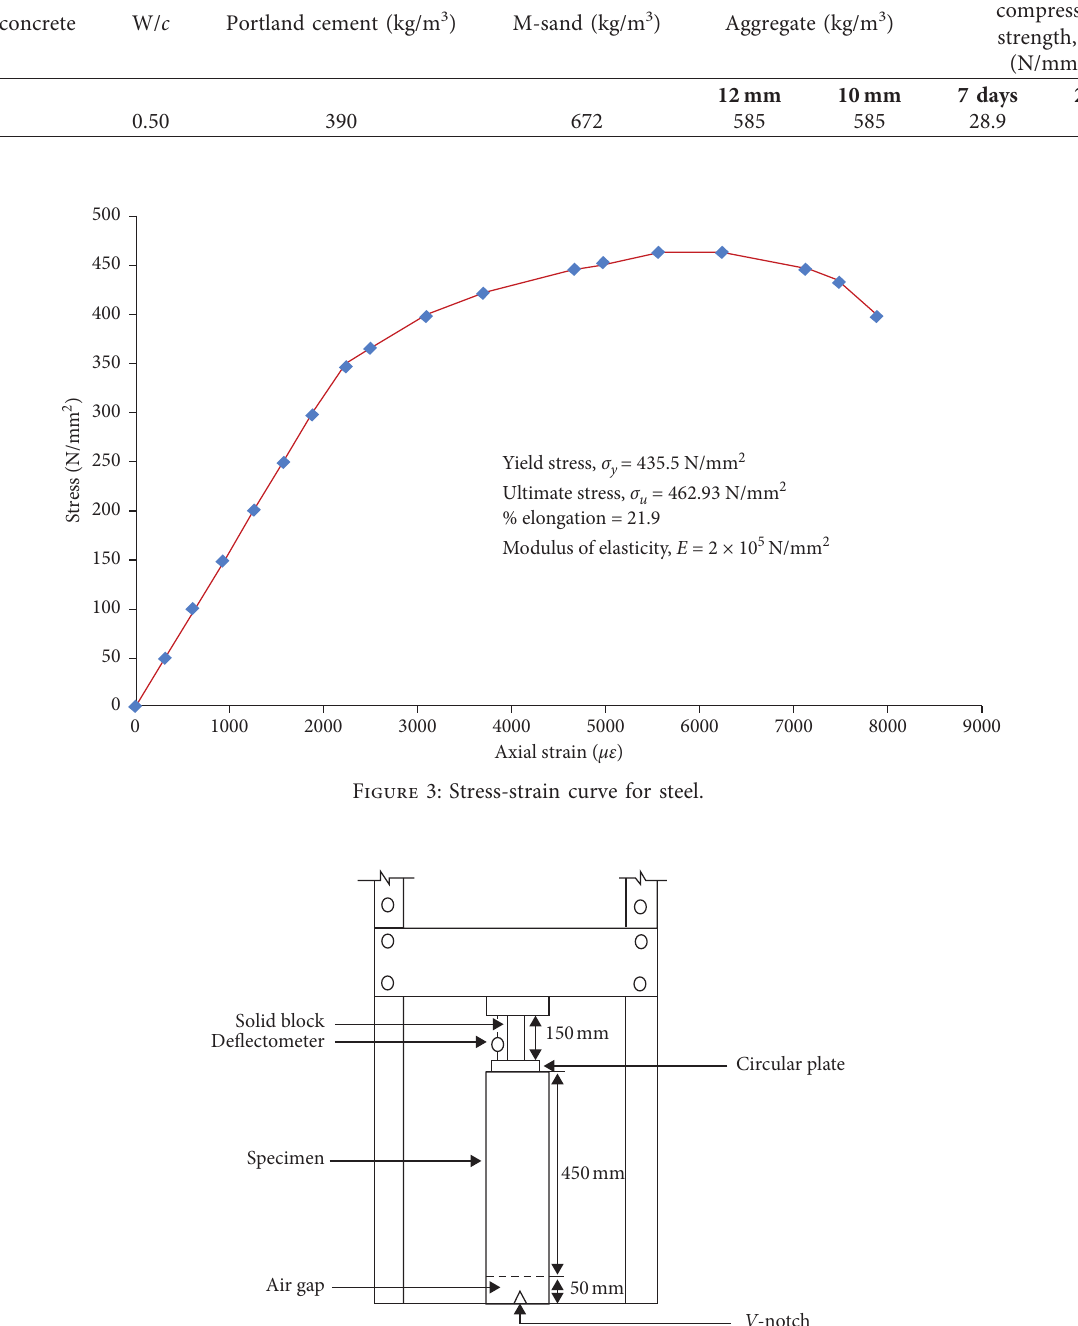
Figure 4: Experimental setup.